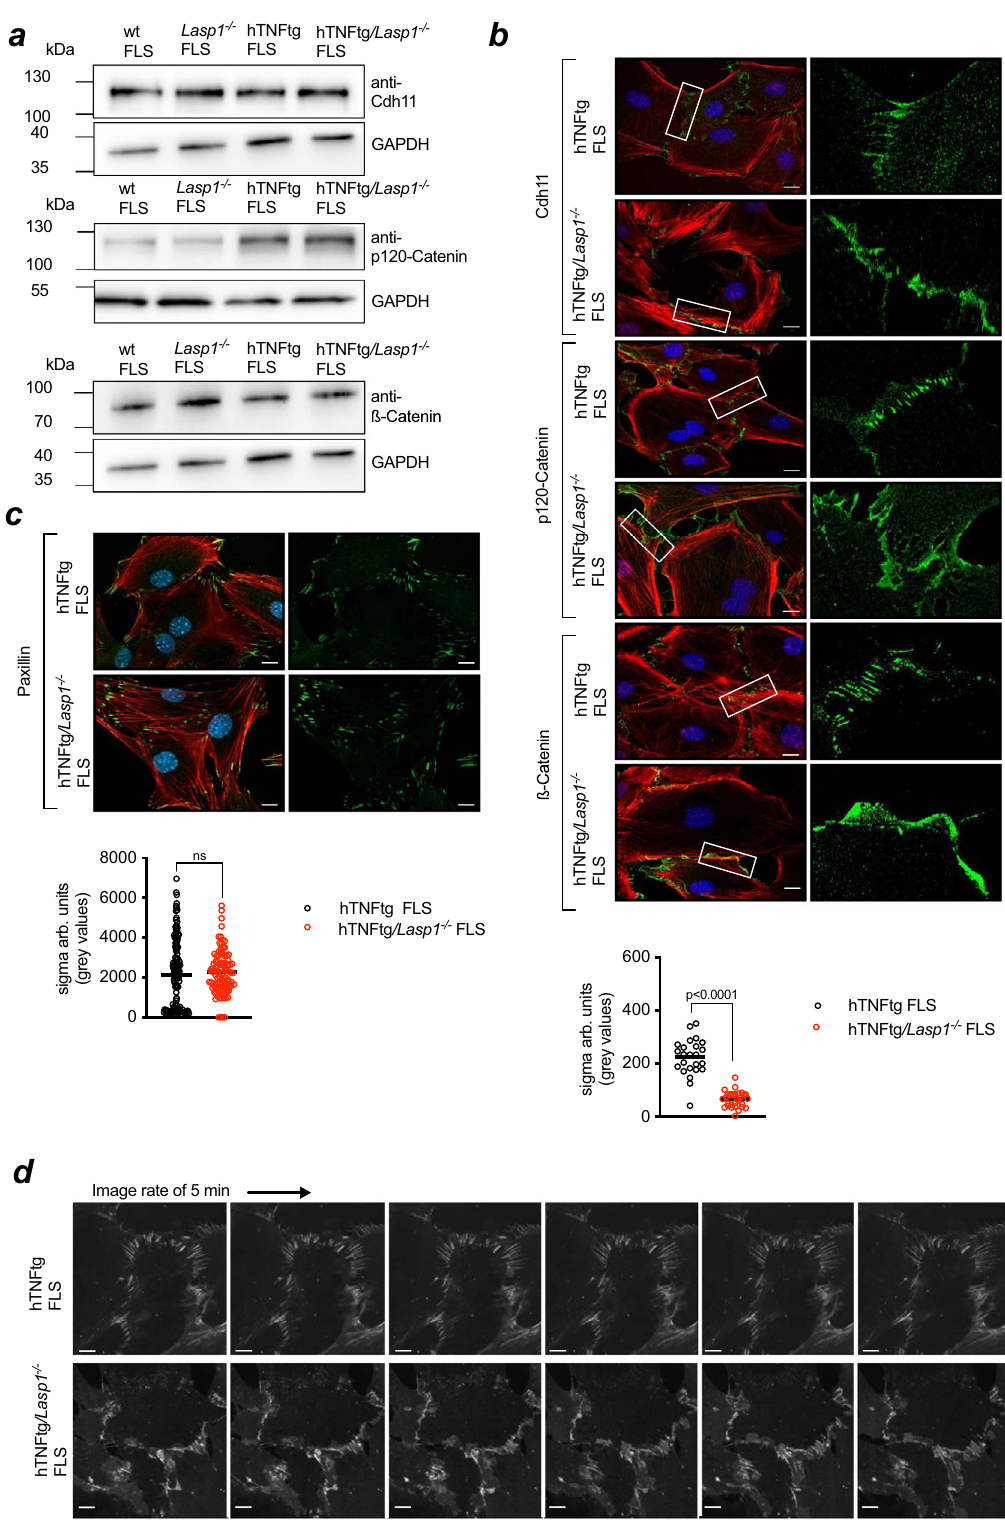
immuno fl uorescence stainings and fl ow cytometry as described before 26 to obtain a more detailed pro fi ling of FLS in lining layer and the sublining layer of the synovium. We analysed the localisation of FLS subtypes at the sites of pannus invasion in hTNFtg and hTNFtg /Lasp1 − / − mice using fi broblast activation protein- α (FAP α ), Podoplanin (PDPN) and thymus cell antigen 1 (THY1, also known as CD90) antibodies. Interestingly, hTNFtg /